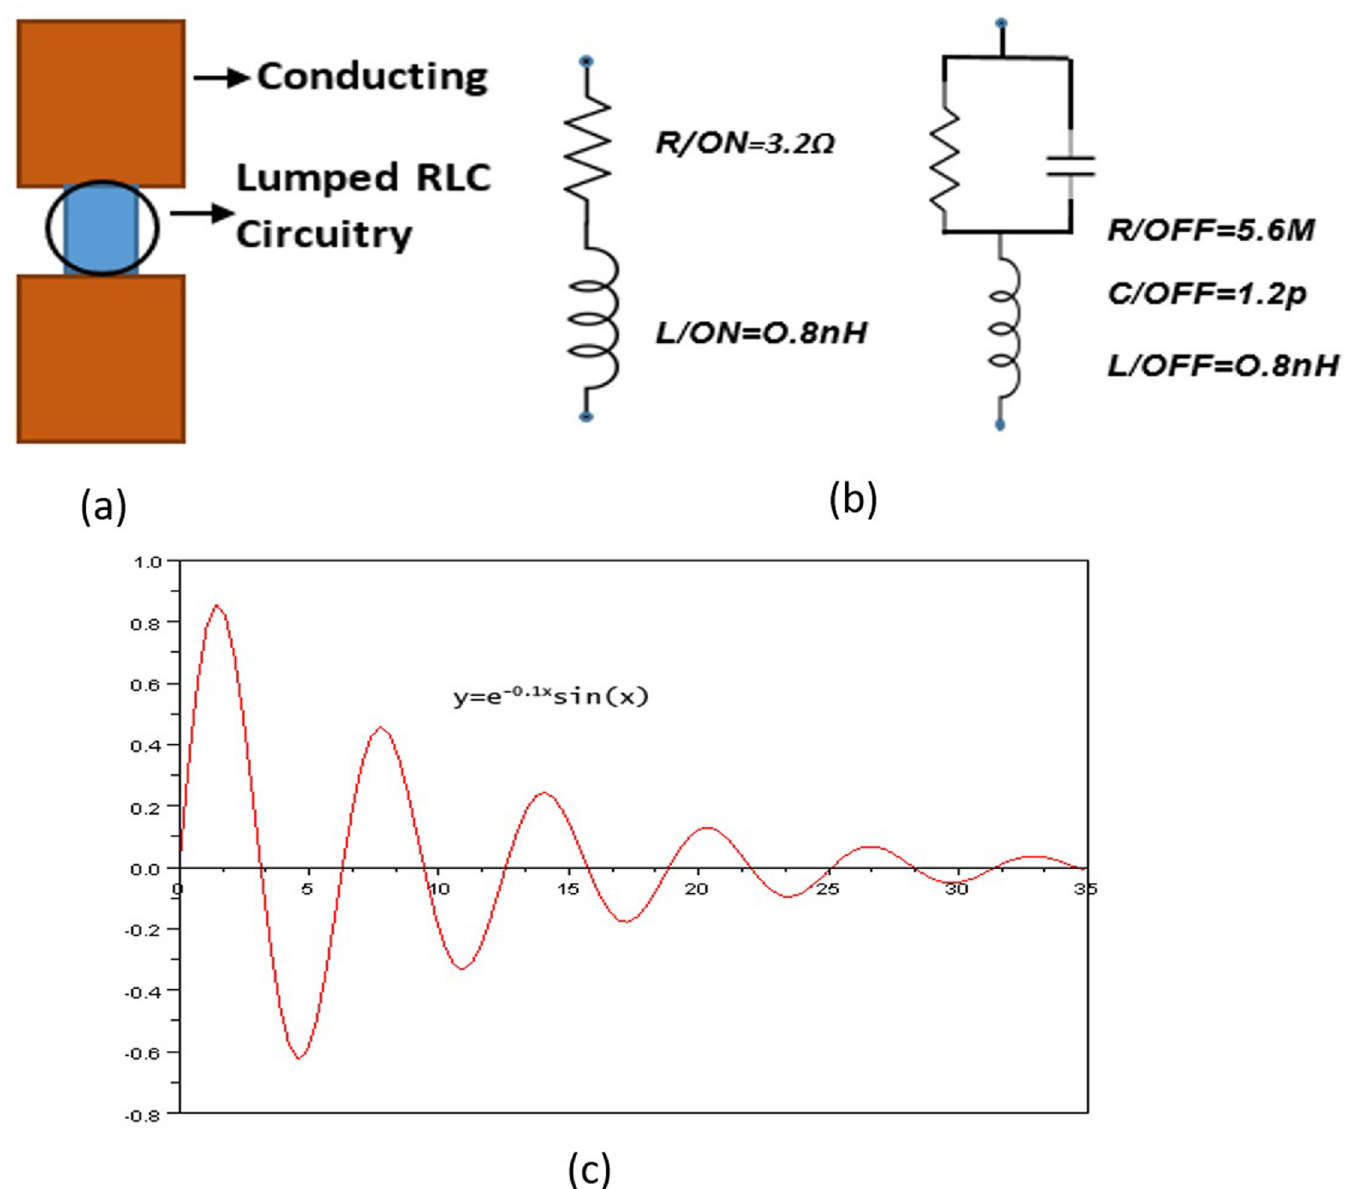
Fig 3. PIN diode structure (a) HFSS PIN Diode Symbol. (b) Ideal equivalent circuit models of PIN diode working at 28/38GHz ON state, OFF state (c) Step Response of RLC switch for oscillation.